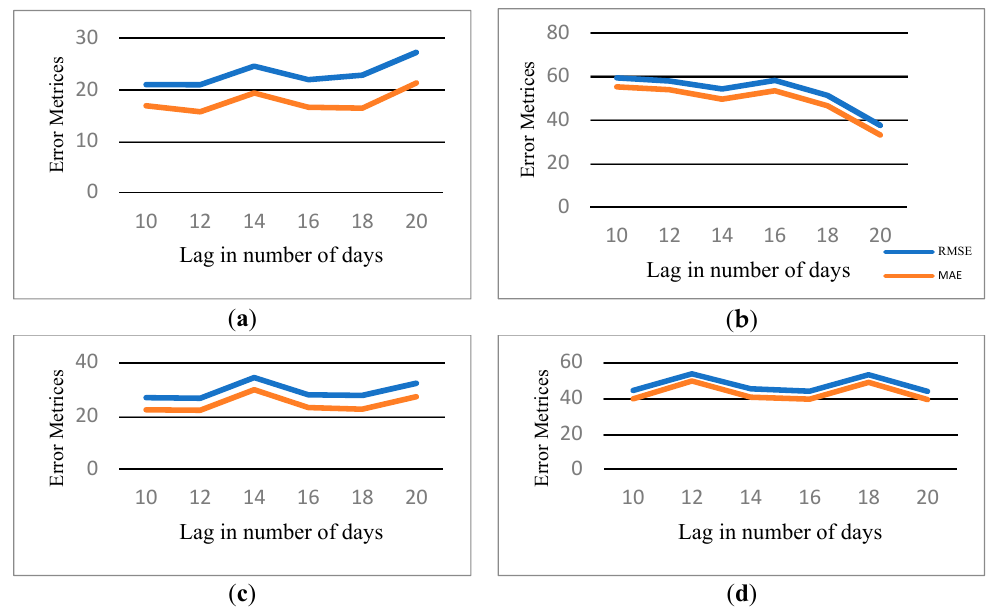
Figure 4. Mean absolute error (MAE) and root mean square error (RMSE) plots at different look-back values: ( a ) long short-term memory (LSTM) with news sentiment; ( b ) LSTM without news sentiment; ( c ) gated recurrent unit (GRU) with news sentiment; and ( d ) GRU without news sentiment.